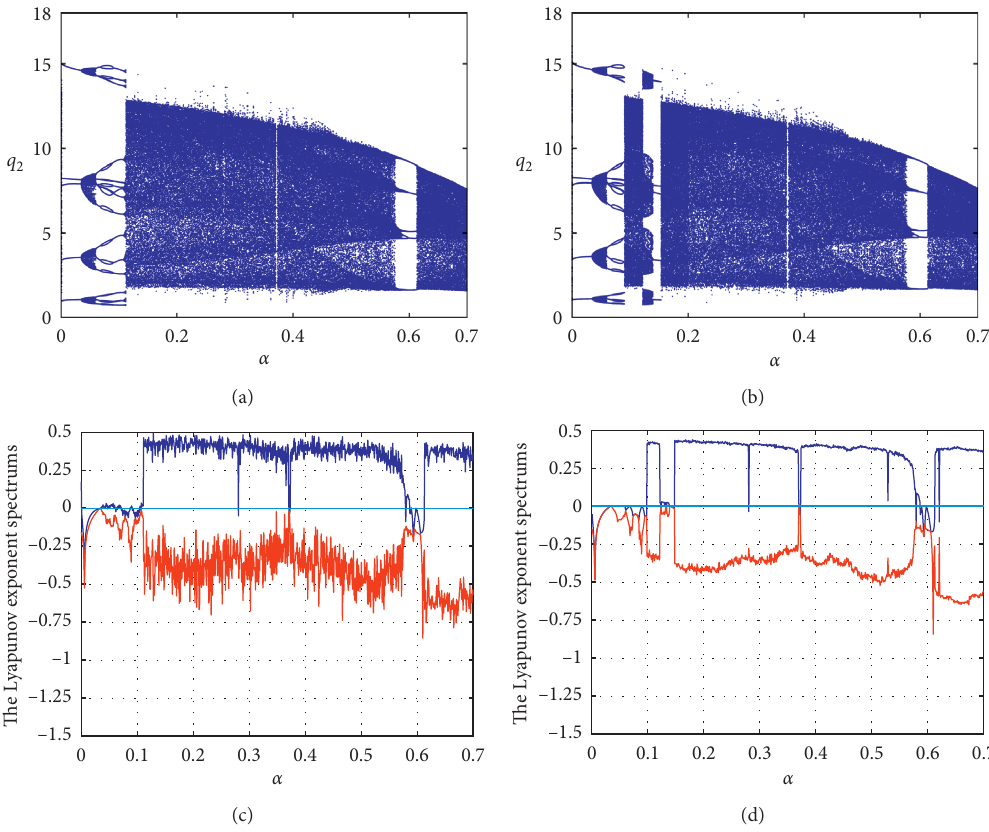
Figure 4: The 1-D bifurcation diagrams with adiabatic initial conditions and the corresponding Lyapunov exponent spectrums, where the parameters are fixed as a − c parameter of α and (b) decreasing parameter of α